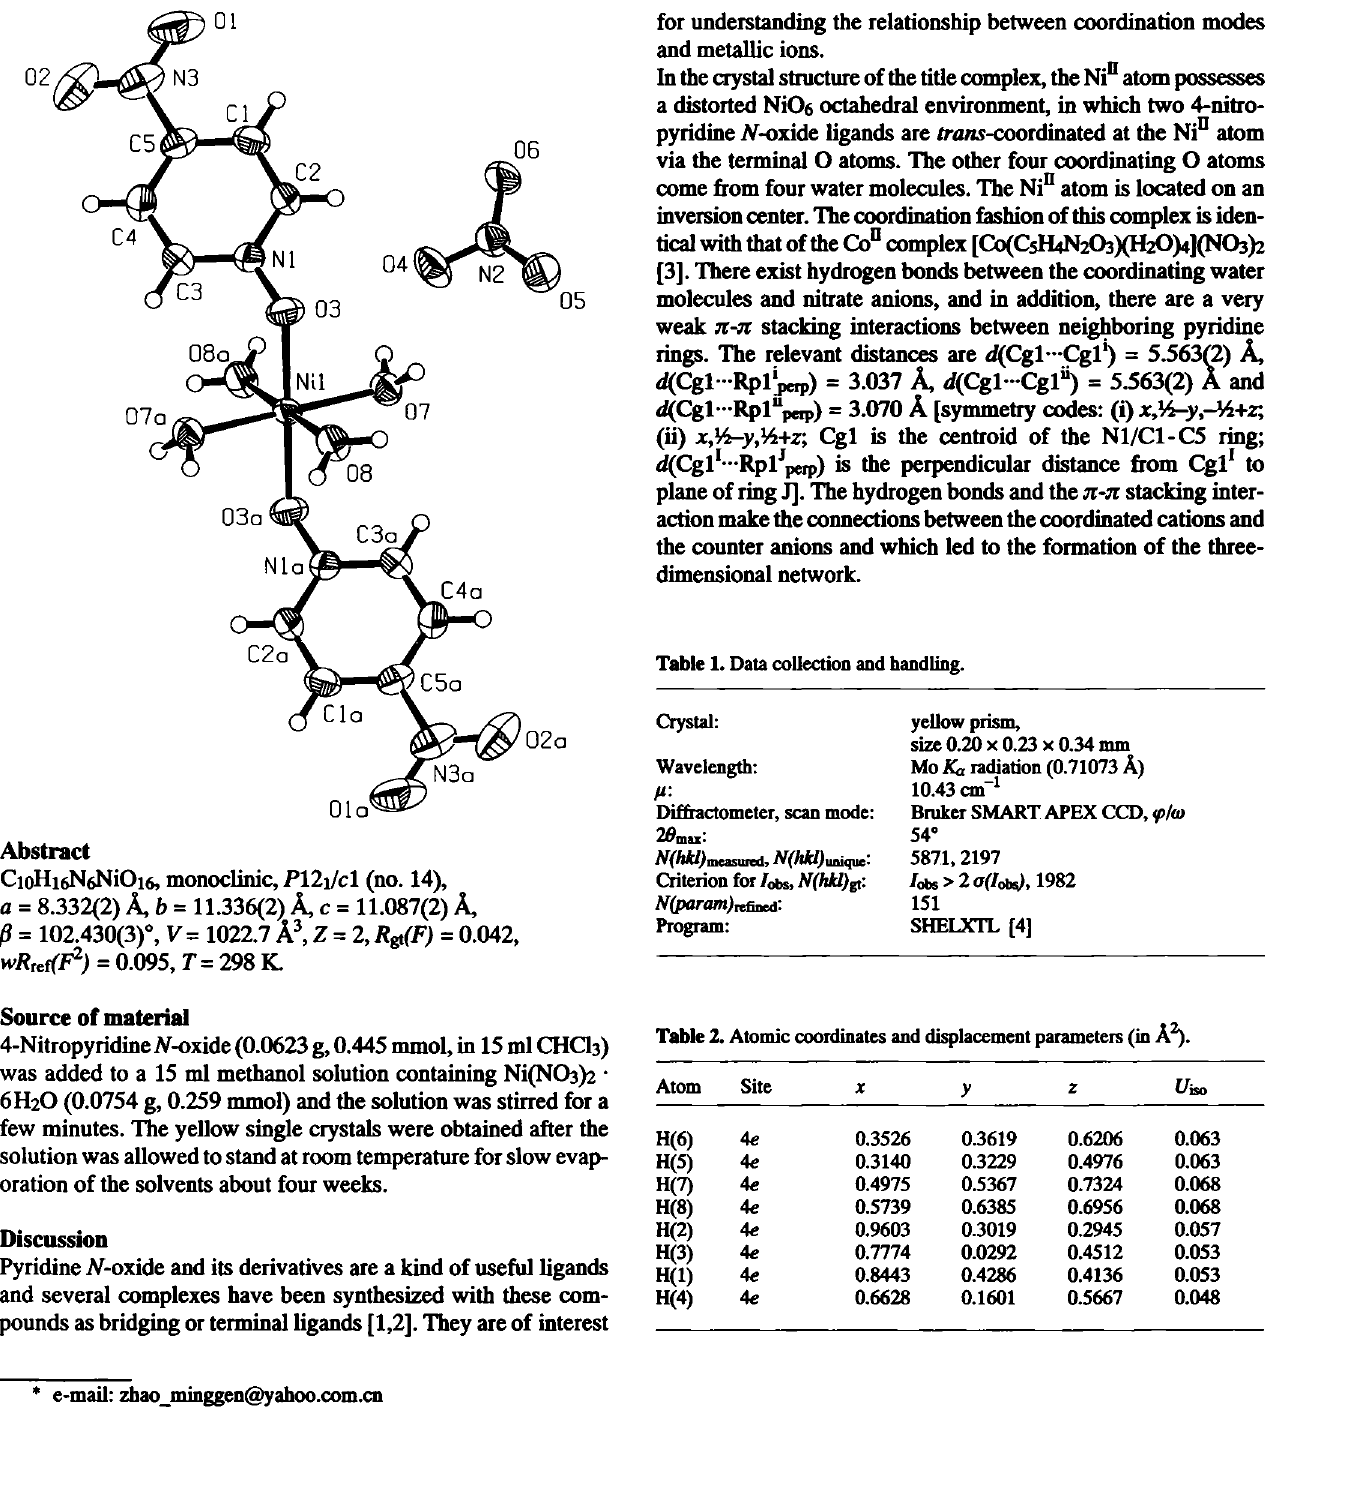
Table 2. Atomic coordinates and displacement parameters (in A 2